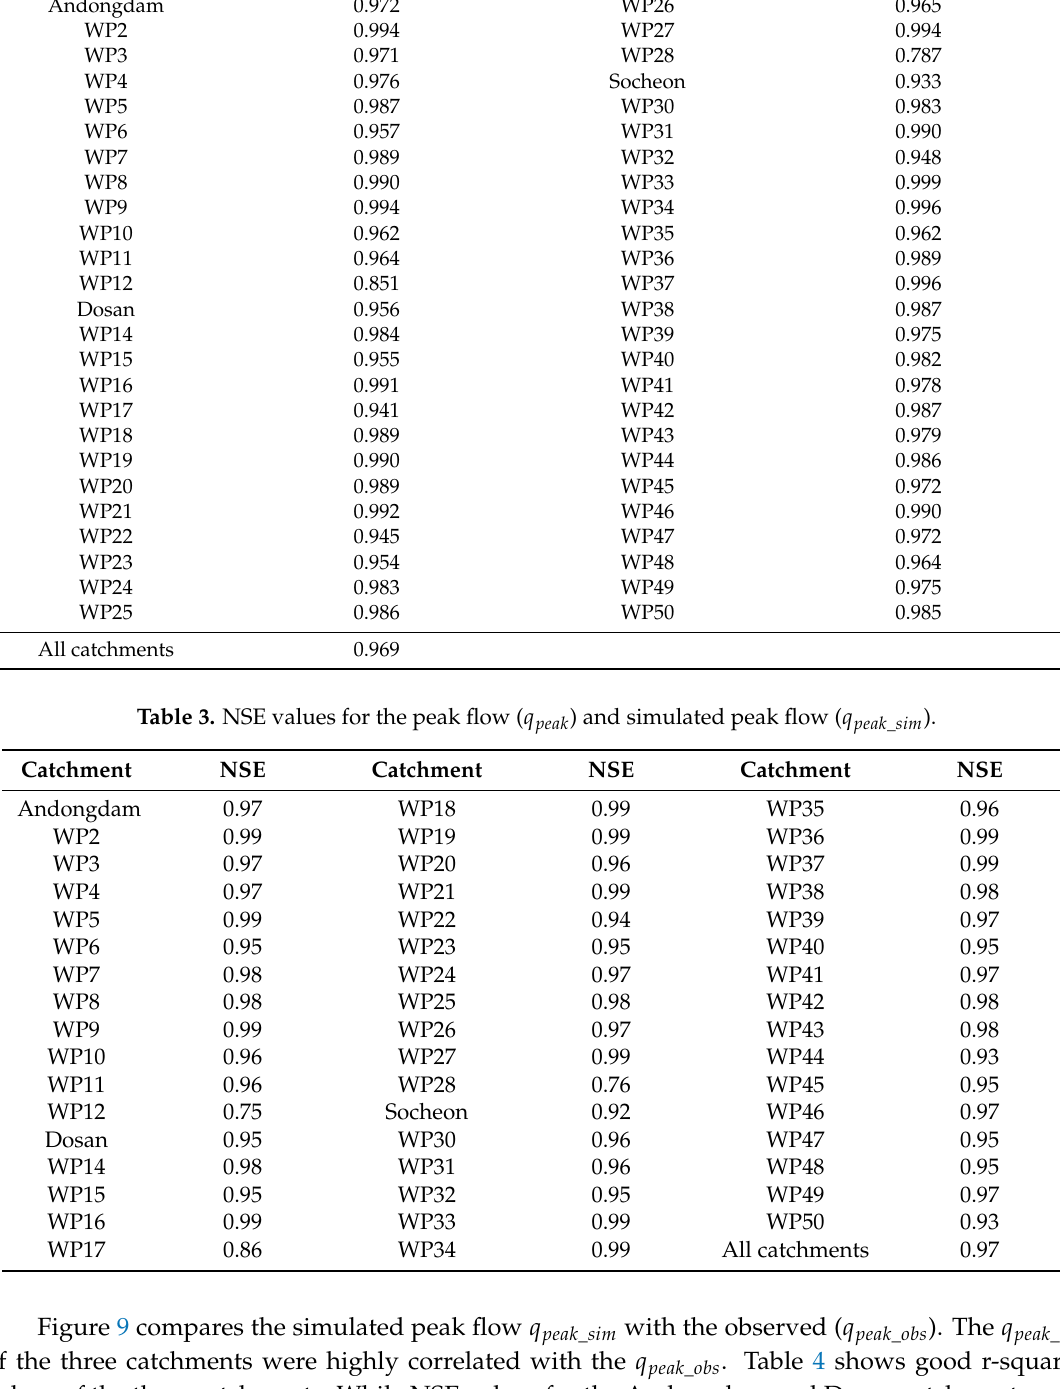
Table 2. R-squared values for the peak flow ( q peak ) and simulated peak flow ( q peak _ sim ). Catchment R-Squared ( q peak and q peak _ sim ) Catchment R-Squared ( q peak and q peak _ sim ) Andongdam